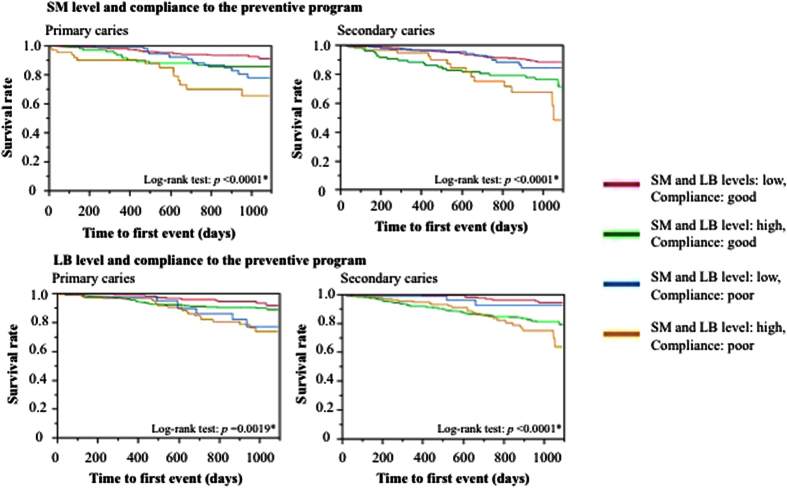
Survival analyses for the incidence of primary and secondary caries, focused on a combination of specific cariogenic bacteria level and compliance with the preventive program using the Kaplan–Meier and log-rank tests.SM level: high (higher than 1 × 106 CFU/ml); low (1 × 106 CFU/ml or lower). LB level: high (1 × 104 CFU/ml or higher); low (lower than 1 × 104 CFU/ml). Each patient’s compliance with the preventive program was categorized as follows: good (regular visits + sometimes delayed visits); poor (irregular visits + emergency visits only). *Statistically significant at a level of p < 0.05.